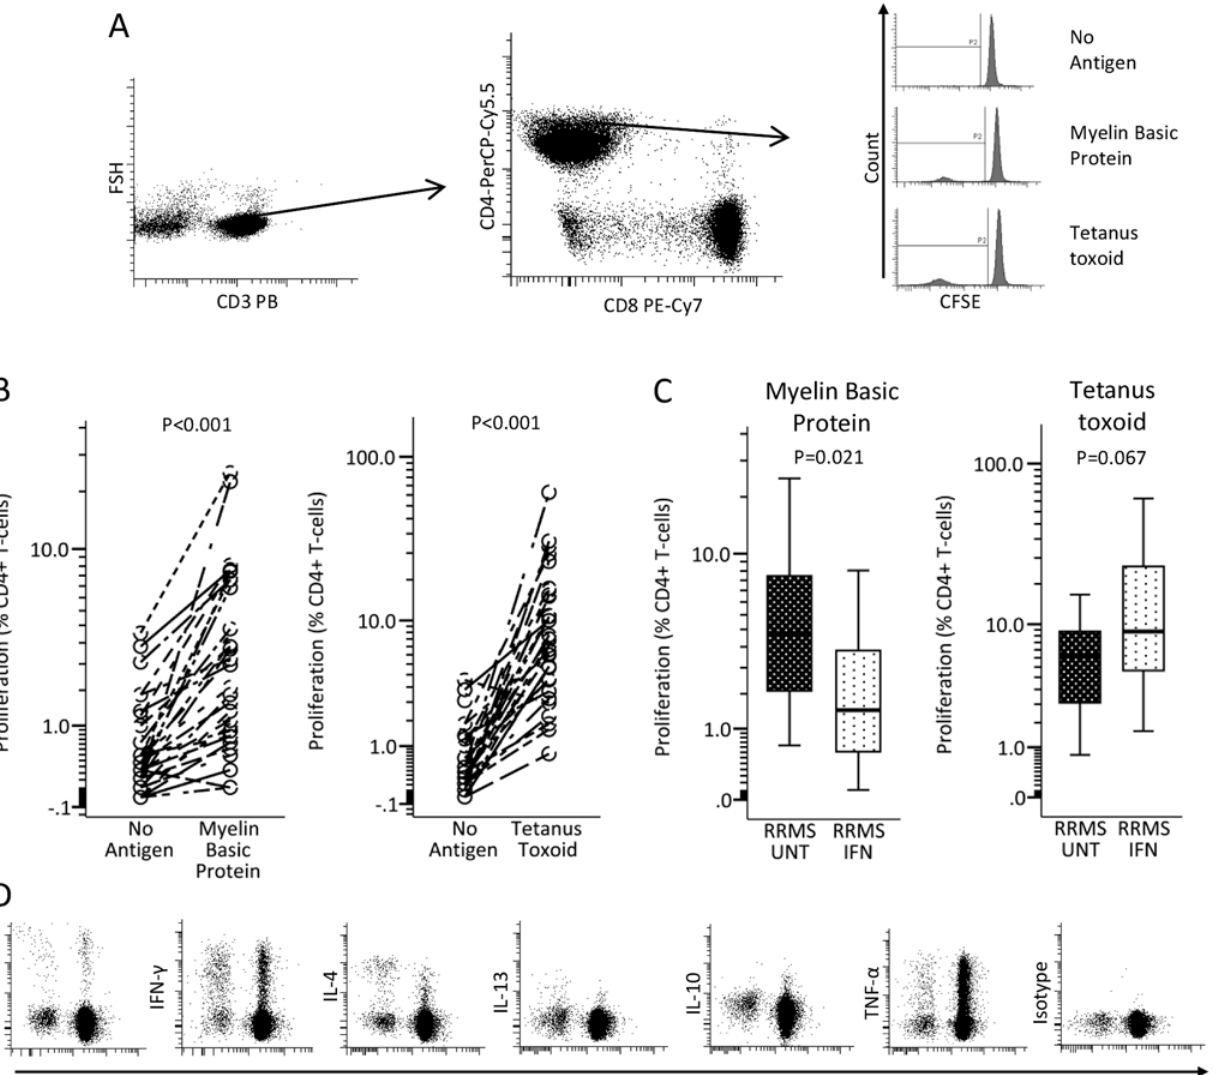
Fig 1. Responsiveness of CD4 + T-cells to myelin basic protein (MBP) and tetanus toxoid (TT) ex vivo . (A) Representative dot plots and histograms showing the gating strategy for measurement of CD4 + T-cell proliferation — before T-cells were identified debris, dead cells and CD19 + cells had been excluded. (B) Graphs shows significant proliferative response of CD4 + T-cell to TT (n = 30; pooled data from 12 untreated and 18 interferon (IFN)- β treated relapsing remitting multiple sclerosis (RRMS) patients from the sub-study 2 population) and MBP (n = 31;pooled data from 13 untreated and 18 IFN- β treated RRMS patients from the sub-study 2 population). (C) Boxplots compare proliferative CD4 + T-cell responses to MBP in 13 untreated and 18 IFN- β treated patients and to TT in 12 untreated and 18 IFN- β -treated MS patients (sub-study 2 population). Boxes represent interquartile range, median value indicated as a line; whiskers represent range. (D) Representative plots of flow cytometry data to assess intracellular-cytokine production in proliferating CD3 + CD8 - cells (data given in Table 3). Statistical analysis was by (B) paired and (C) unpaired t-test.